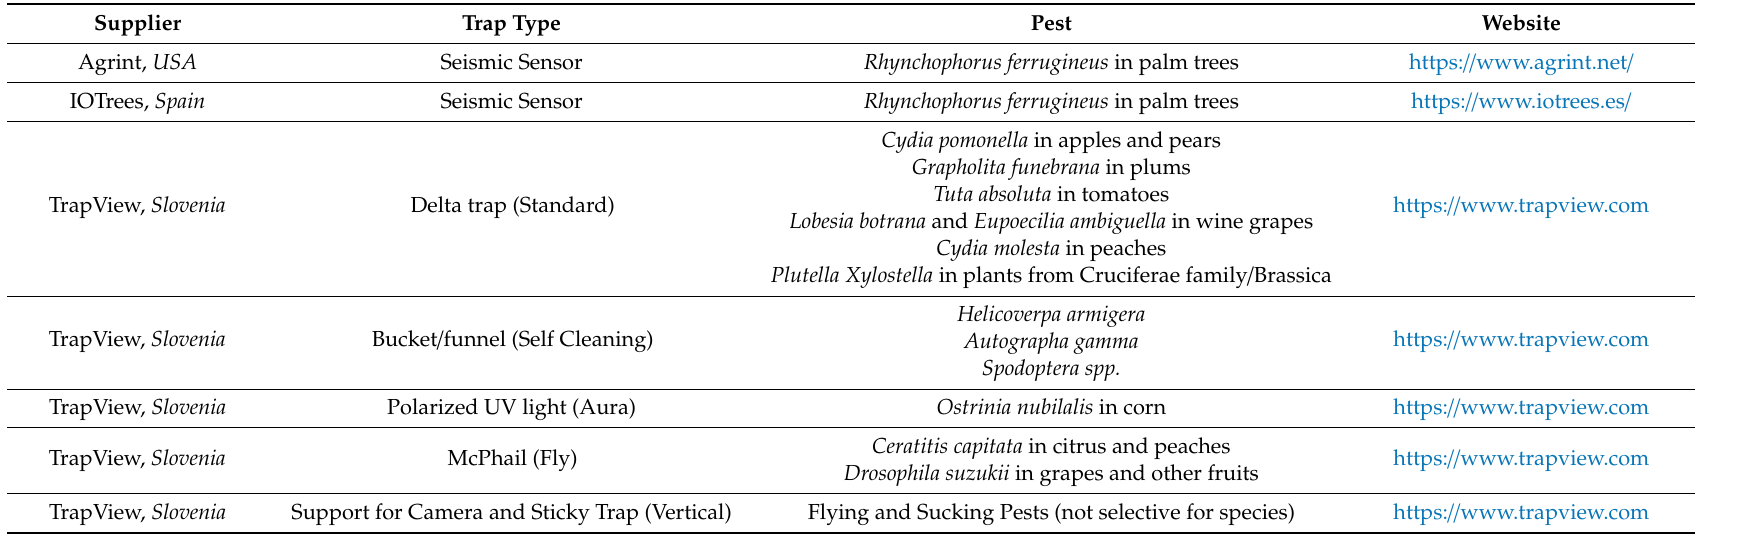
Table A2. List of Commercial Suppliers of Automatic Detection of Pests